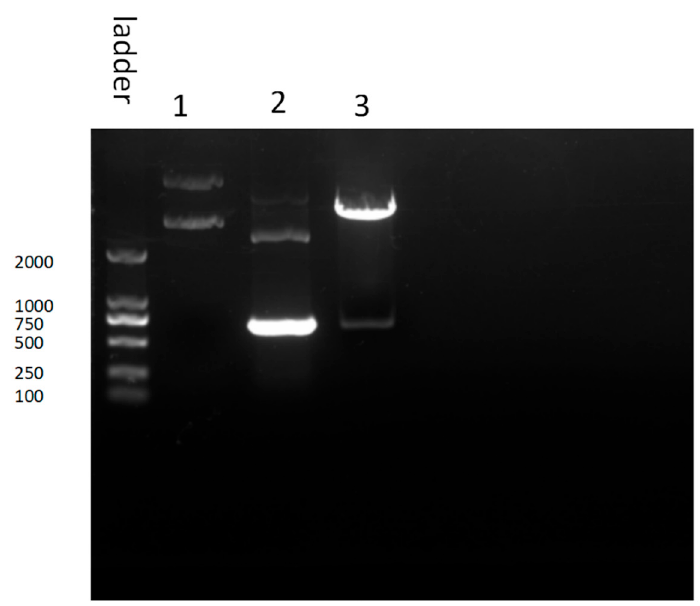
Figure 2. Construction of GRA3-GST plasmid. Line 1 reflects the agarose gel electrophoresis results of GST-GRA3 plasmid mixed with 10 × Loading Buffer. Line 2 reflects that after PCR of the GRA3-GST plasmid, the band of GRA3 was 680 bp. Line 3 reflects the results of agarose-gel electrophoresis of GRA3-GST plasmid digested by Xco R1 and Eco R1 enzymes and mixed with 10 × Loading Buffer. The results were consistent with those of the PCR.